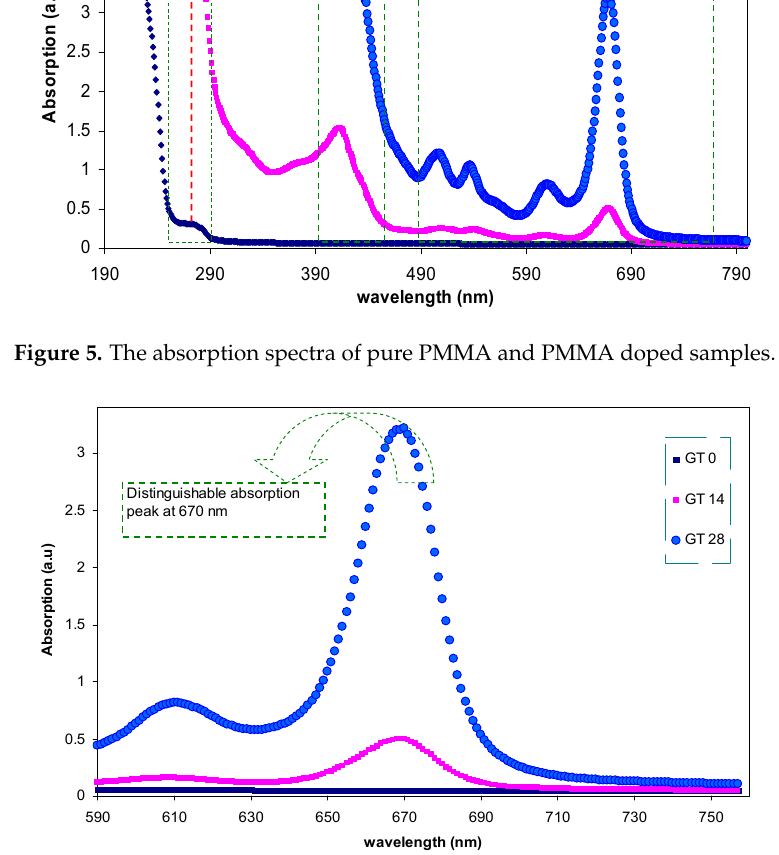
Figure 6. The absorption spectra of pure PMMA and PMMA doped samples at longer wavelengths.